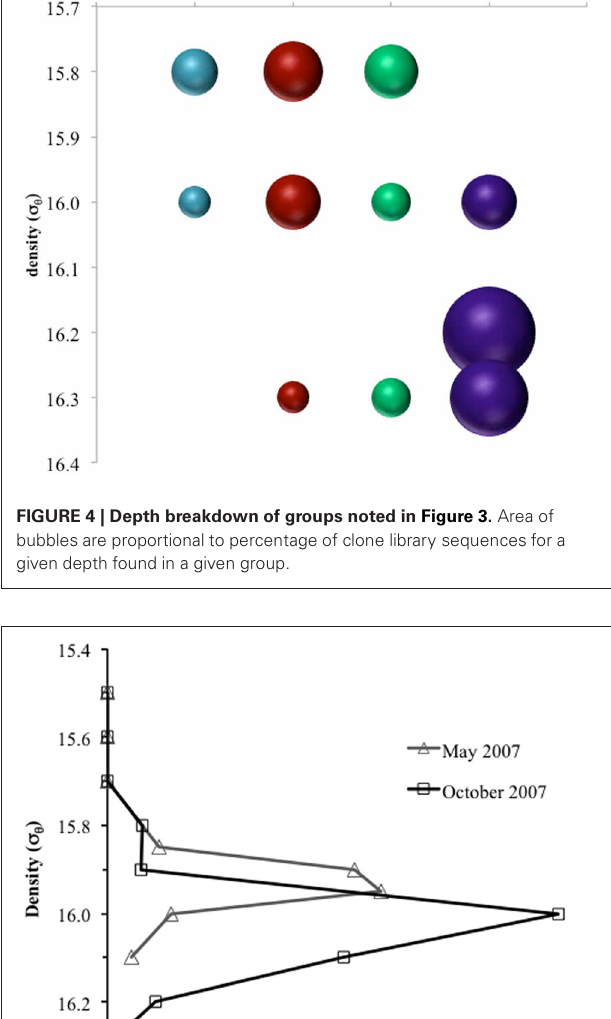
ranged from σ θ = 15 . 8 to 16.2 with a maximum at σ θ = 15 . 95 in May and σ θ = 16 . 0 in October ( Figure 5